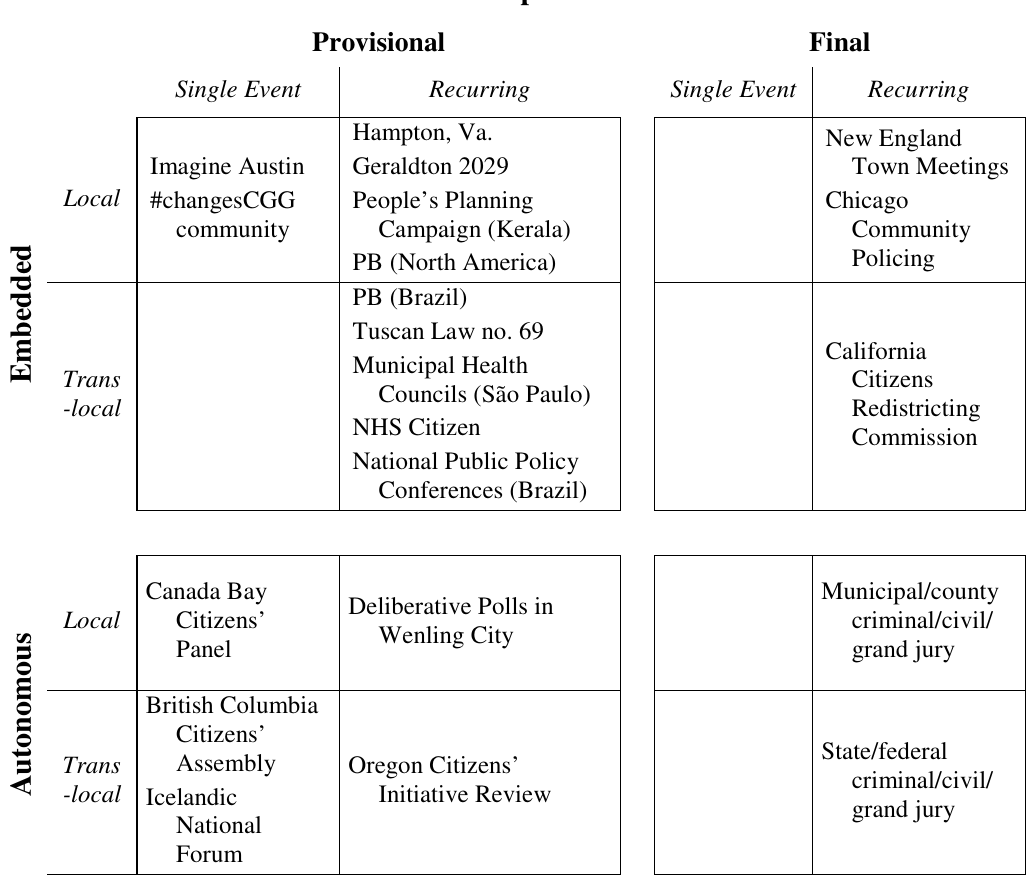
Table 1: Varieties of Empowered Deliberation